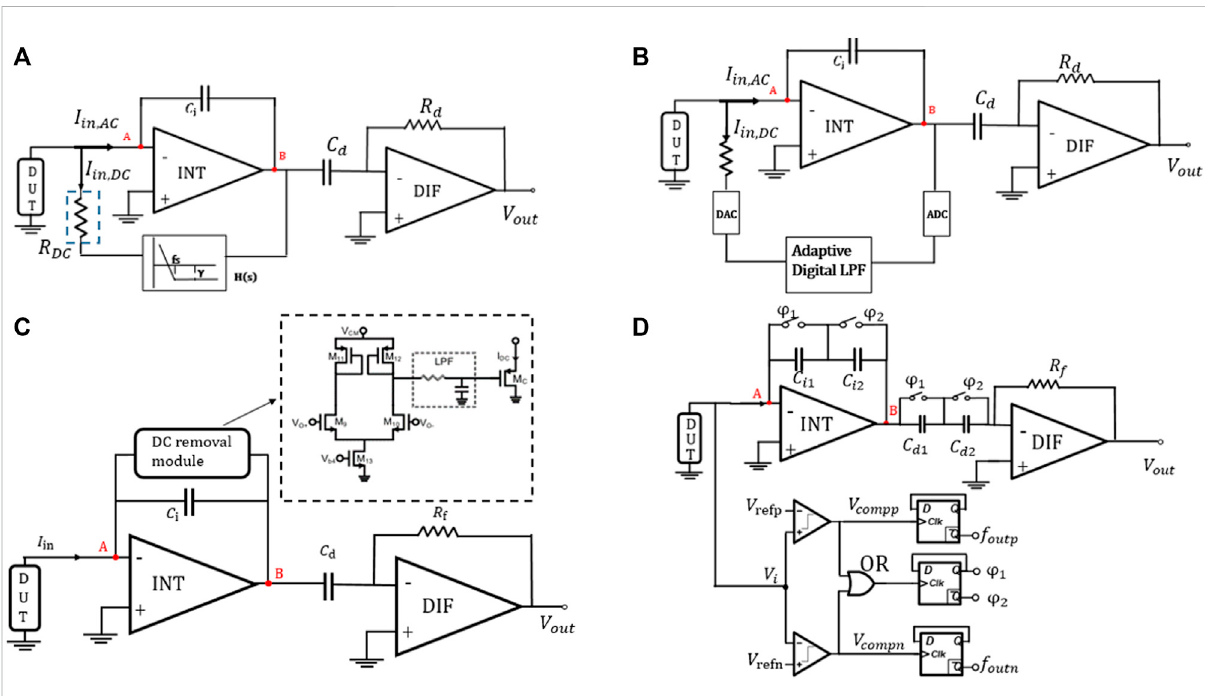
FIGURE 9 (A) Continuous-time approach with R and H(s) as the feedback network (Ferrari et al., 2009), (B) continuous-time approach with an adaptive feedbacknetwork(Hsuetal.,2015), (C) continuous-timeapproachwithadifferentialcircuitandlow-pass fi lter(Taherzadeh-Sanietal.,2017),and (D) continuous-time approach with a fi xed-threshold window comparator (Dai et al.,